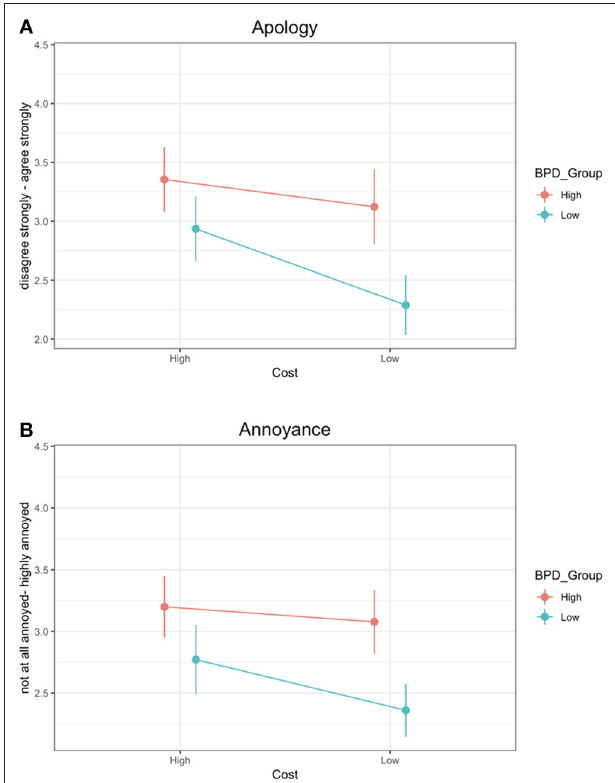
FIGURE 2 | Results from the two test questions for the High BDP and Low BPD groups in the High Cost and Low Cost conditions. Error bars represent the confidence intervals. (A) shows responses to the apology question (“To what extent would you agree Pam owes you an apology?”). (B) shows responses to the annoyance question (“If Pam did not apologize or offer any explanation, how annoyed would you be?”).